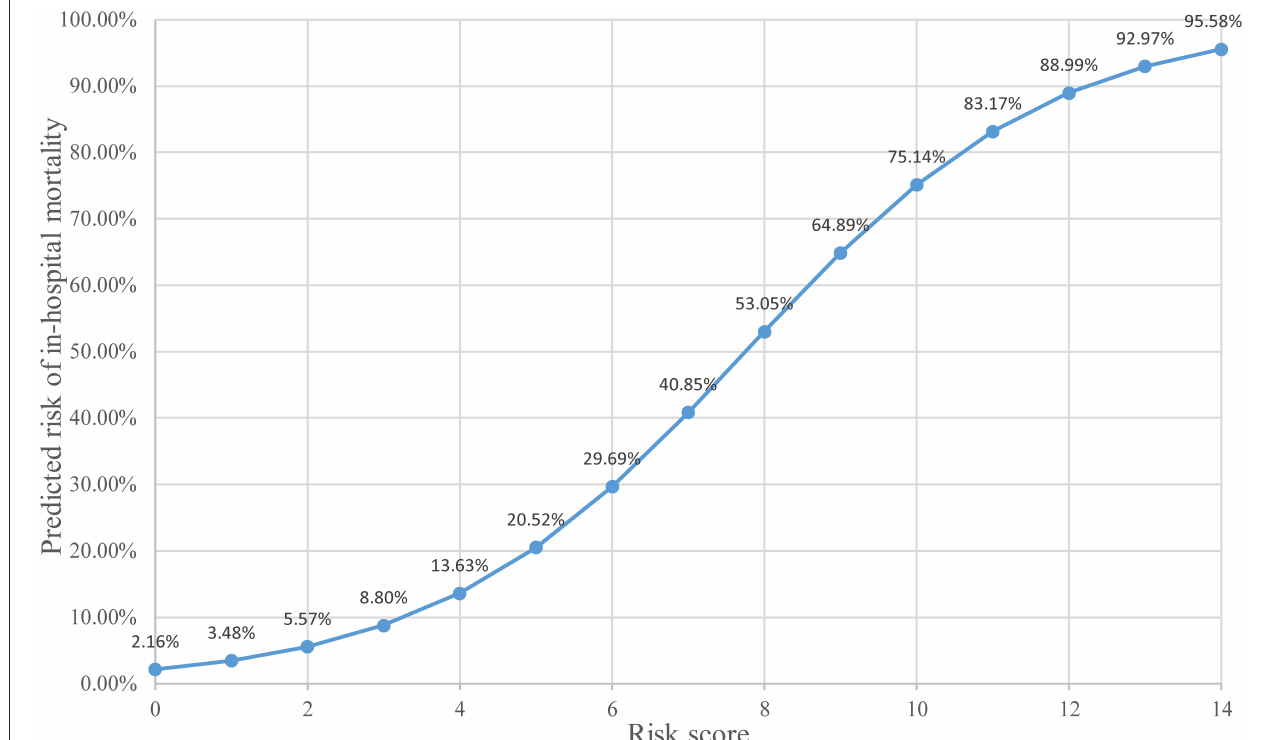
FIGURE 3 | Different risk score correspond to different risk prediction